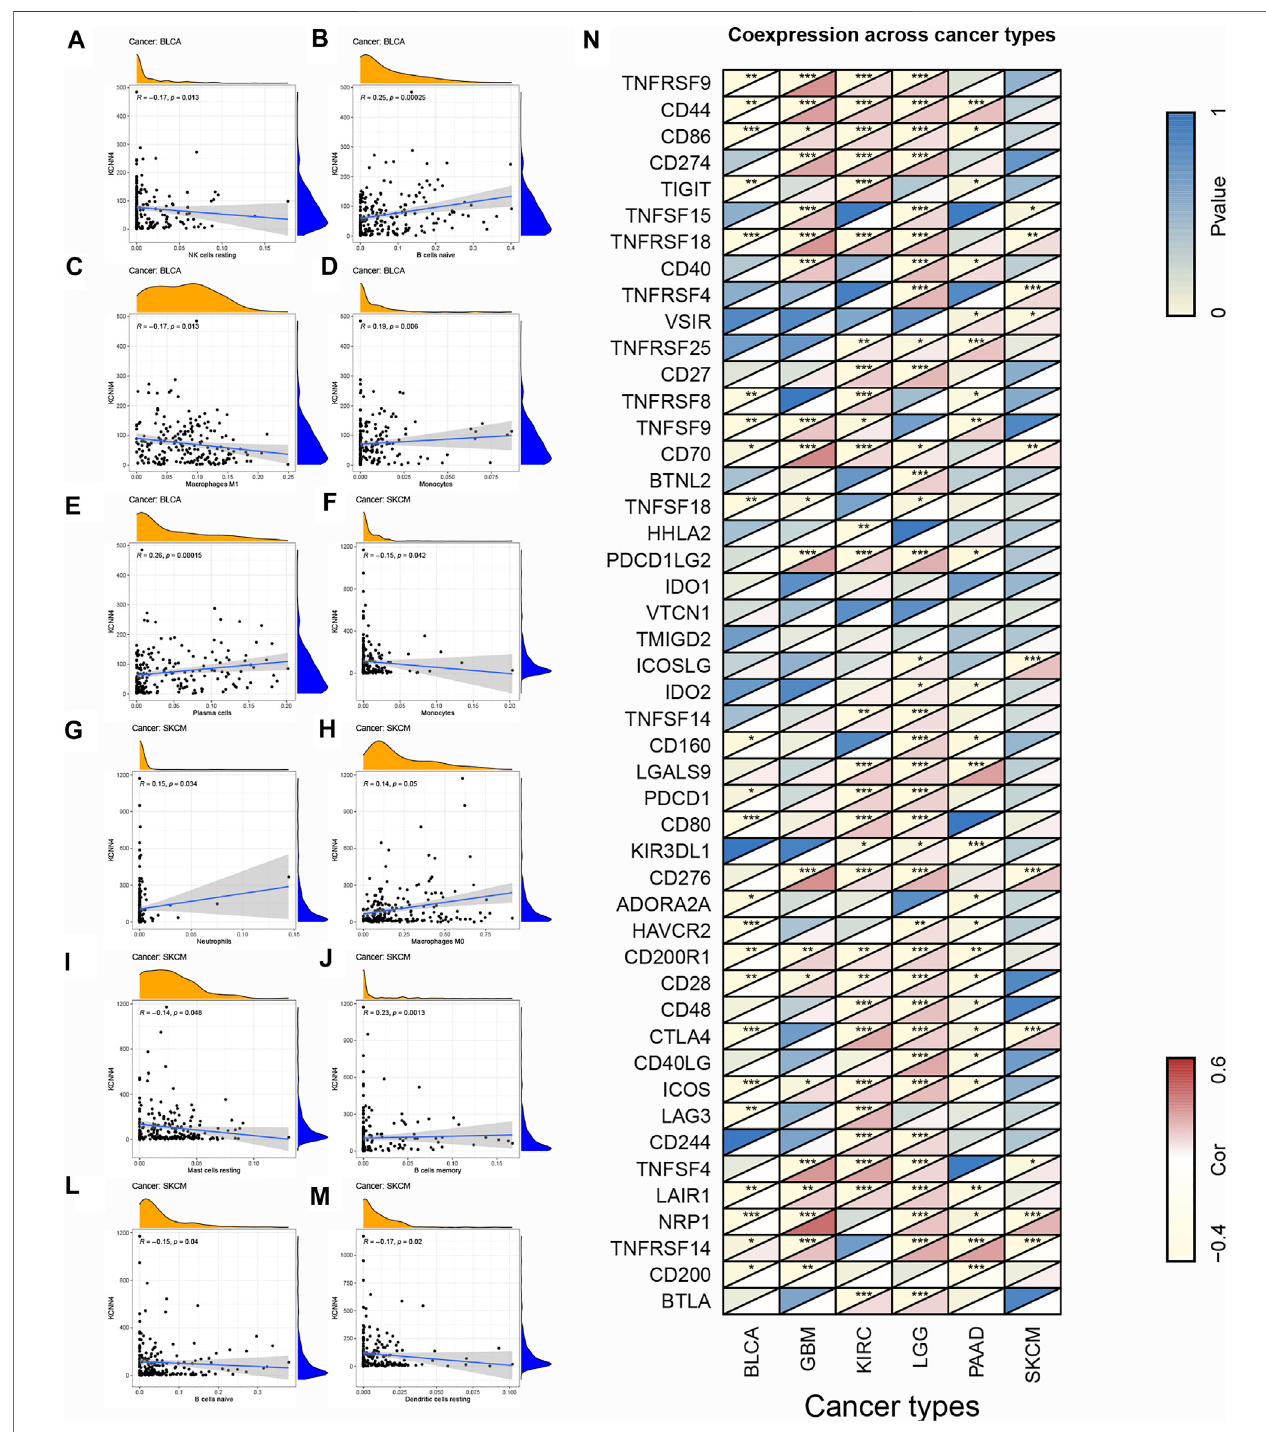
FIGURE 10 | Association of TIC subtype with KCNN4 expression in decreased-risk group and the association of KCNN4 expression with immune-related genes. (A – E) Association of each TIC subtype with KCNN4 expression in BLCA. (F – M) Association of each TIC subtype with KCNN4 expression in SKCM. (N) Correlation between KCNN4 expression and immune-related